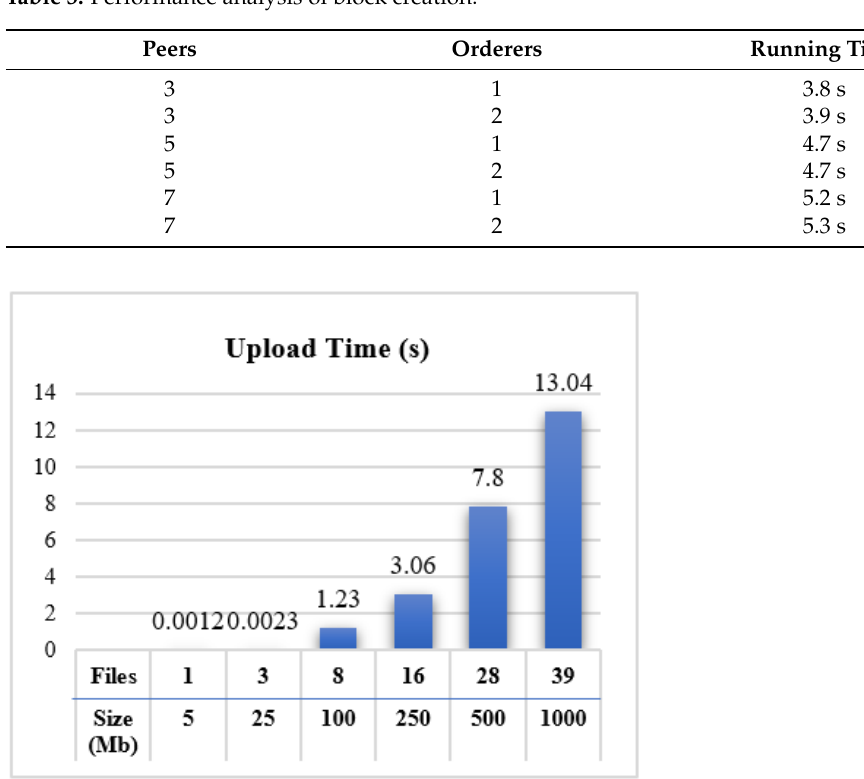
Figure 11. Downloading performance in